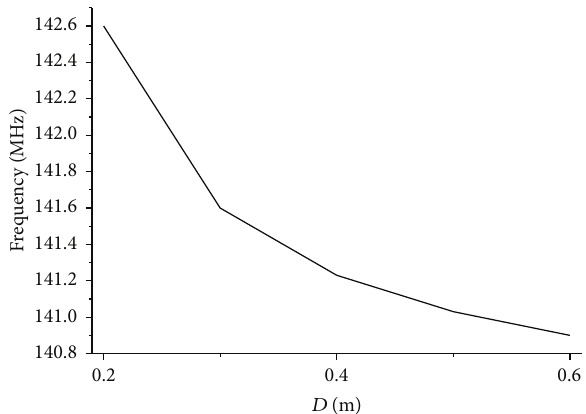
Figure 22: Optimum frequency of case 4 for maximum efficiency PTE mat against separation 𝐷